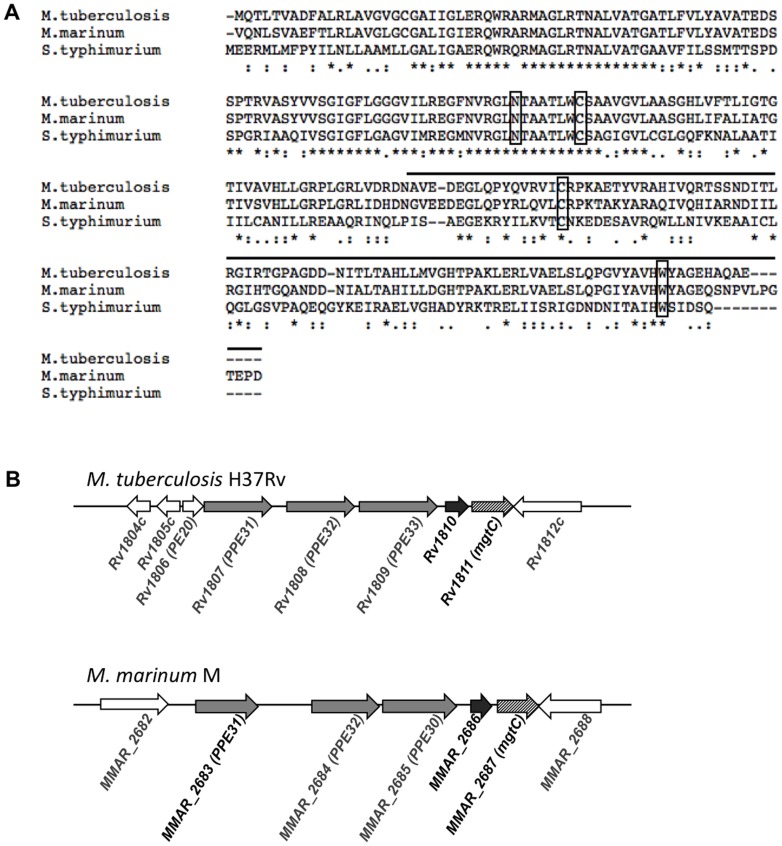
Alignment of mycobacterial MgtC proteins and genetic environment of mgtC gene.(A) Alignment of S. Typhimurium MgtC (Accession Number AAL22622.1), M. tuberculosis MgtC (Accession Number NP_216327.1) and M. marinum MgtC (Accession Number ACC41130.1) using ClustalW. The upper line indicates the soluble C terminal part. Rectangles indicate four conserved residues that have been shown to be essential for Salmonella MgtC function. (B) Genetic environment of mgtC gene (striped arrows) in M. tuberculosis and M. marinum genomes. In both species, the mgtC gene is adjacent to Rv1810 that is homologous to MMAR_2686 (black arrows) and to PPE genes (grey arrows). The MMAR_2688 gene is homologous to Rv1812c.